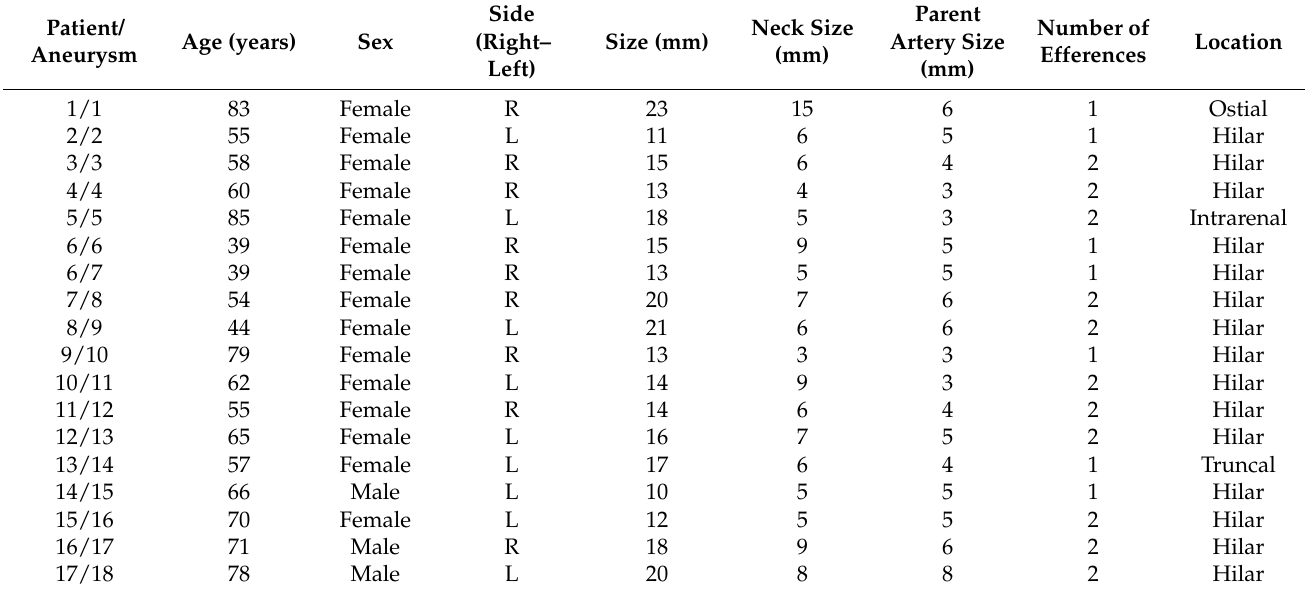
Table 1. Characteristics of the 18 patients and 19 aneurysms.